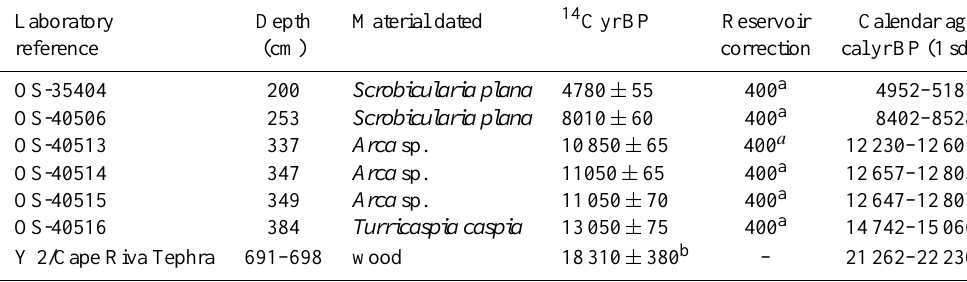
Table 1. AMS-radiocarbon dates on core MD01-2430.